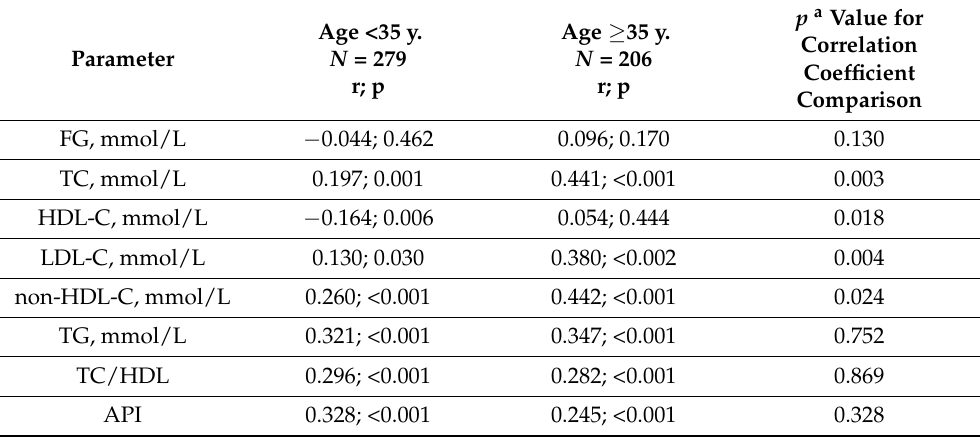
Table 2. The results of Pearson correlation analysis for sdLDL with metabolic parameters and atherogenic indexes in both age groups.